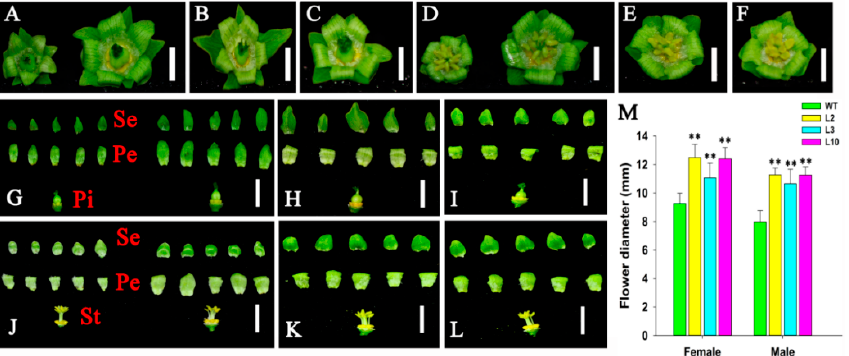
Figure 6. Comparison of the flower morphology between the wild-type (WT) and JcDAD1 -RNAi transgenic plants. ( A ) Female flowers in the WT (left) and transgenic line L2 (right). ( B , C ) Female flowers of the transgenic lines L3 and L10, respectively. ( D ) Male flowers of the WT (left) and transgenic line L2 (right) Jatropha plants. ( E , F ) Male flowers of the transgenic lines L3 and L10, respectively. ( G ) Anatomy of female flowers of the WT (left) and transgenic line L2 (right). ( H ) and ( I ) Anatomy of the female flowers of the transgenic lines L3 and L10, respectively. ( J ) Anatomy of the male flowers of the WT (left) and transgenic line L2 (right). ( K , L ) Anatomy of the male flowers of the transgenic lines L3 and L10, respectively. Bars = 0.5 cm shown in ( A − F ); bars = 1.0 cm shown in ( G − L ). ( M ) Statistics of female and male flower size in the WT and transgenic JcDAD1 -RNAi plants, n ≥ 31. Pe, petal; Pi, pistil; Se, sepal; St, stamen. Error bars represent the standard deviations. Student’s t -test was performed to analyze significant differences. ** Extremely significant difference ( p < 0.01).